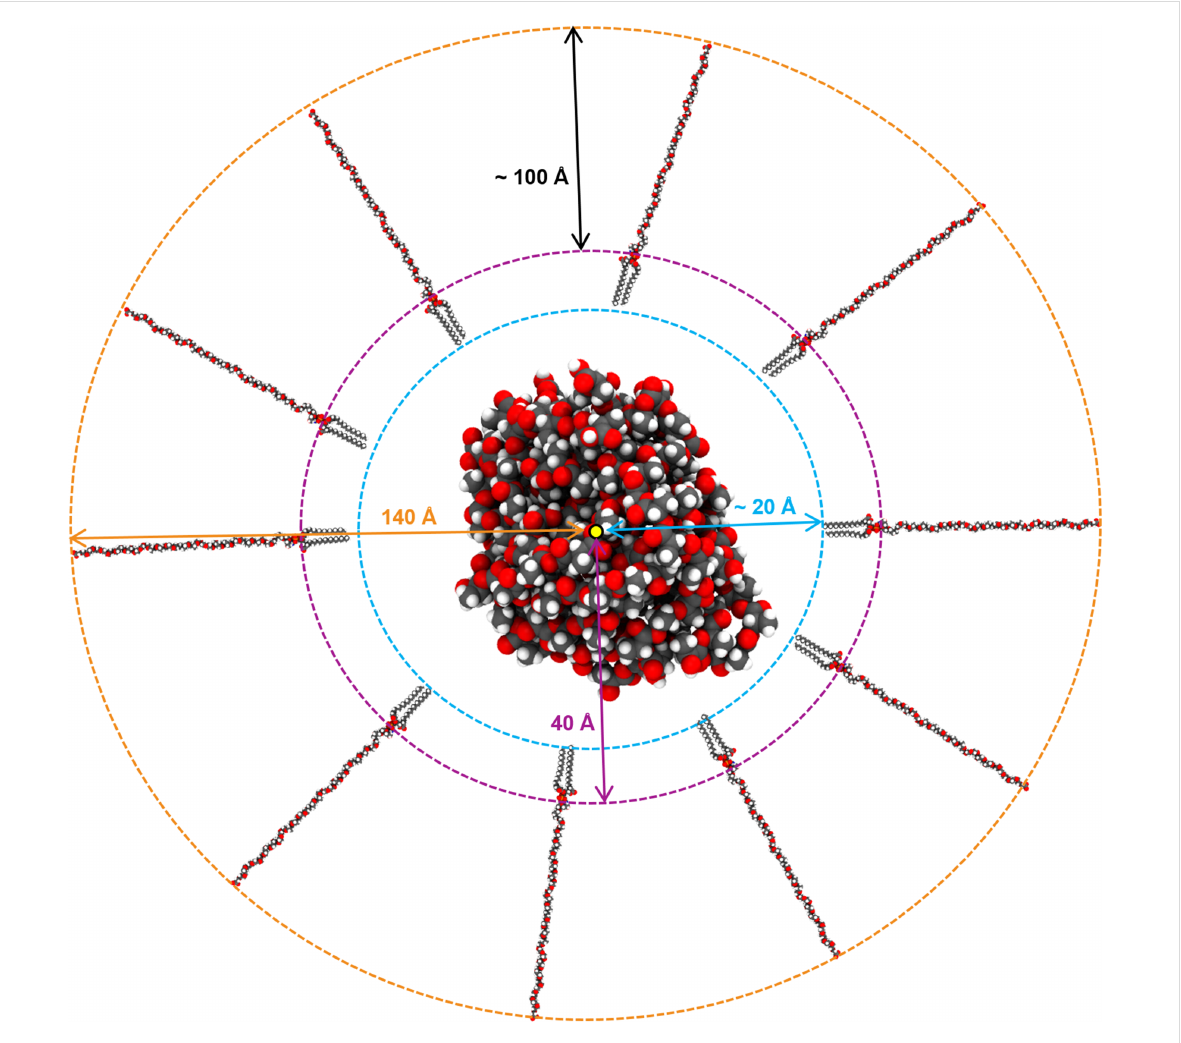
Figure 4: Schematic representation of the initial structure for DSPE–PEG coating process. The PLA core is represented with spheres using conven- tional color coding. The center of mass is represented by a yellow sphere at the center of the PLA core. The dotted lines represent the different boundary areas, such as core–lipid interface (cyan dotted line), polar zone (purple dotted line) and surface charge (orange dotted line). The distance between the center of mass and the boundary areas is represented using the same color as the dotted